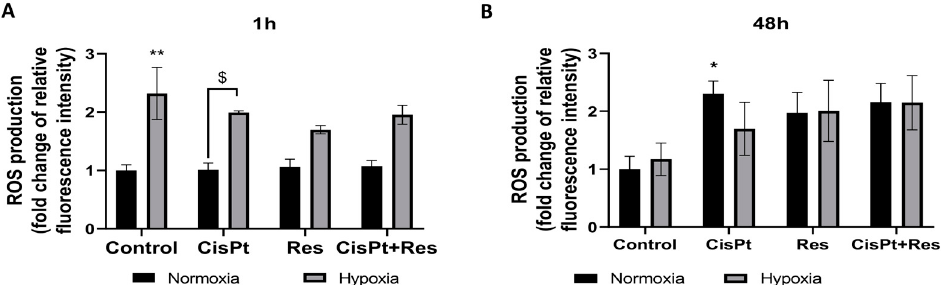
Figure 5. Hypoxia-dependent production of intracellular reactive oxygen species in A2780 cells upon treatment with cisplatin, resveratrol, and in combination. The cells were treated with cisplatin (CisPt), resveratrol (Res), and both in combination (CisPt+Res) according to Section 4.4: Establishment of Hypoxic Culture Conditions and Experimental Outline. The intracellular ROS were assayed by 5 µM DCF-DA staining for 30 min. at 37 °C, followed by flow cytometry analysis. ( A ) ROS production after one hour; ( B ) after 48 h treatment with drugs. The results of three independent experiments are presented as mean values ± SEM, normalized to the normoxia control as 1. ** p < 0.01, * p < 0.05 vs. normoxia control; $ p < 0.05, CisPt in normoxia vs. CisPt in hypoxia.